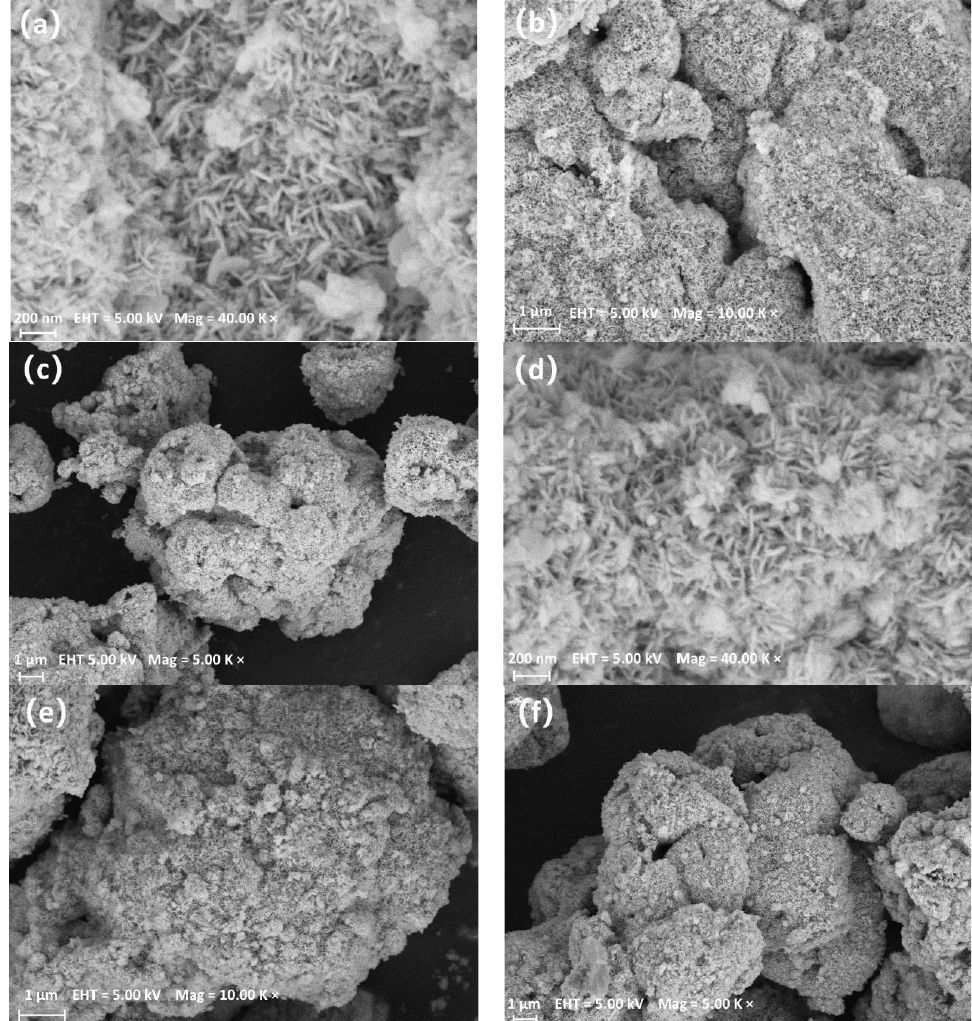
Figure 2. SEM images of BiOBr 0.85 I 0.15 , ( a – c ); 1.0%Ag/BiOBr 0.85 I 0.15 , ( d – f ).